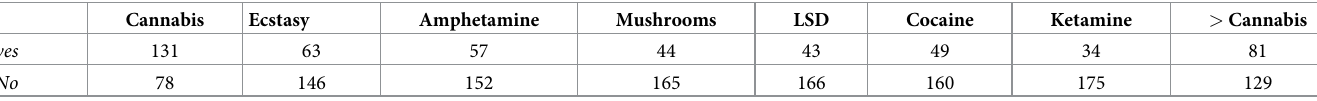
Absolute number of